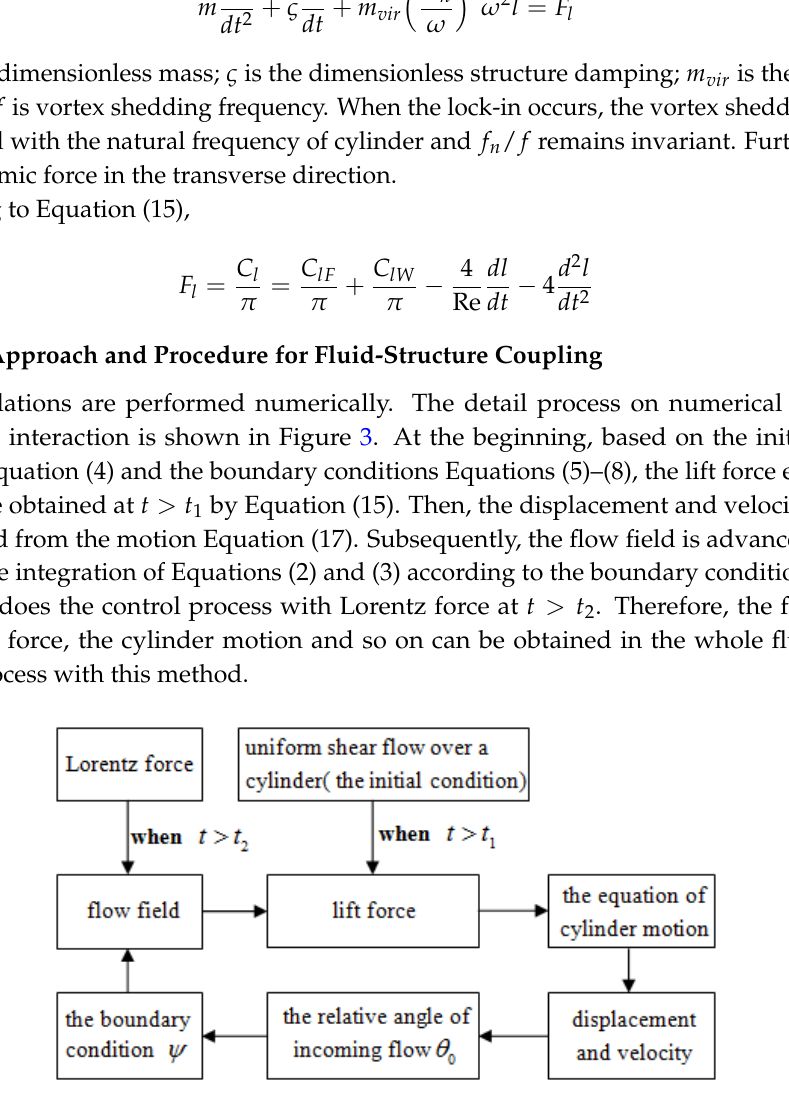
Figure 3. The detailed process of the numerical procedure of fluid–structure interaction.